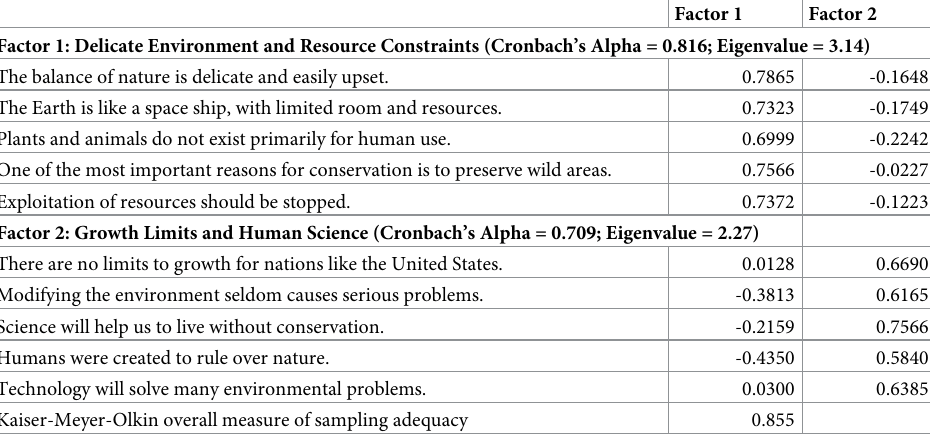
Table 1. Principal component factor analysis results for environmental paradigm survey